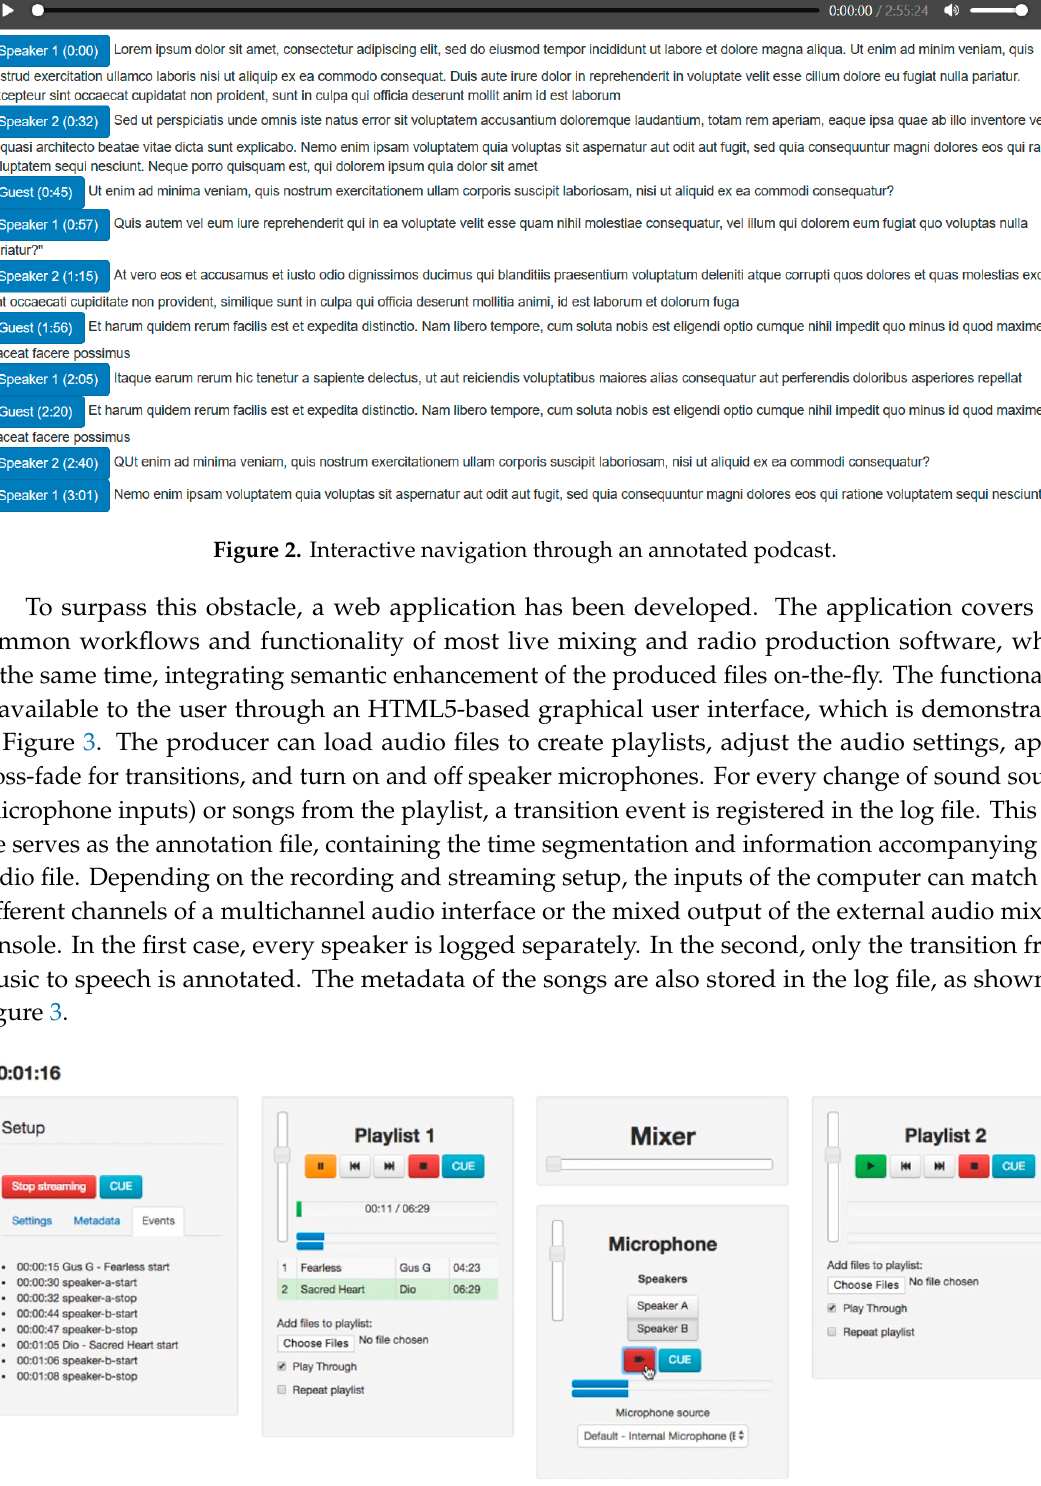
Figure 3. Graphical user interface of the web application for live mixing, annotation, and broadcasting.